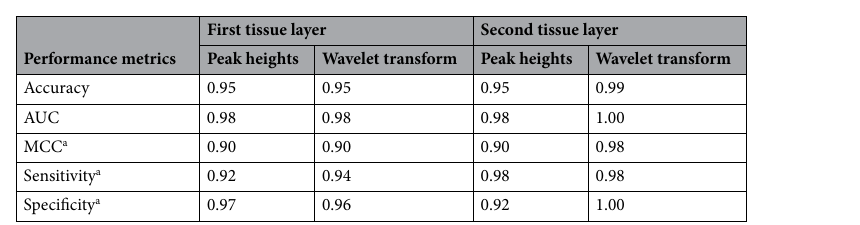
Table 2. Tissue classification scores for both the first and second layers, using the two different feature extraction methods. a Fat was considered as the positive class.